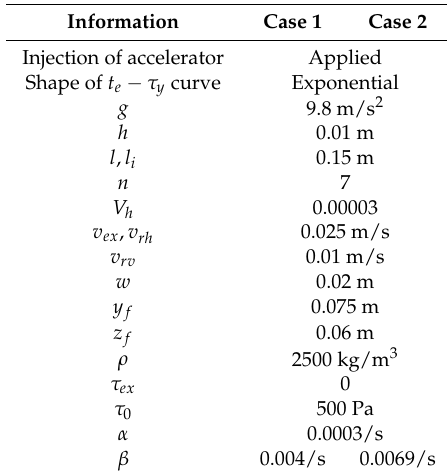
Table 1. Summary of printing properties for analysis.